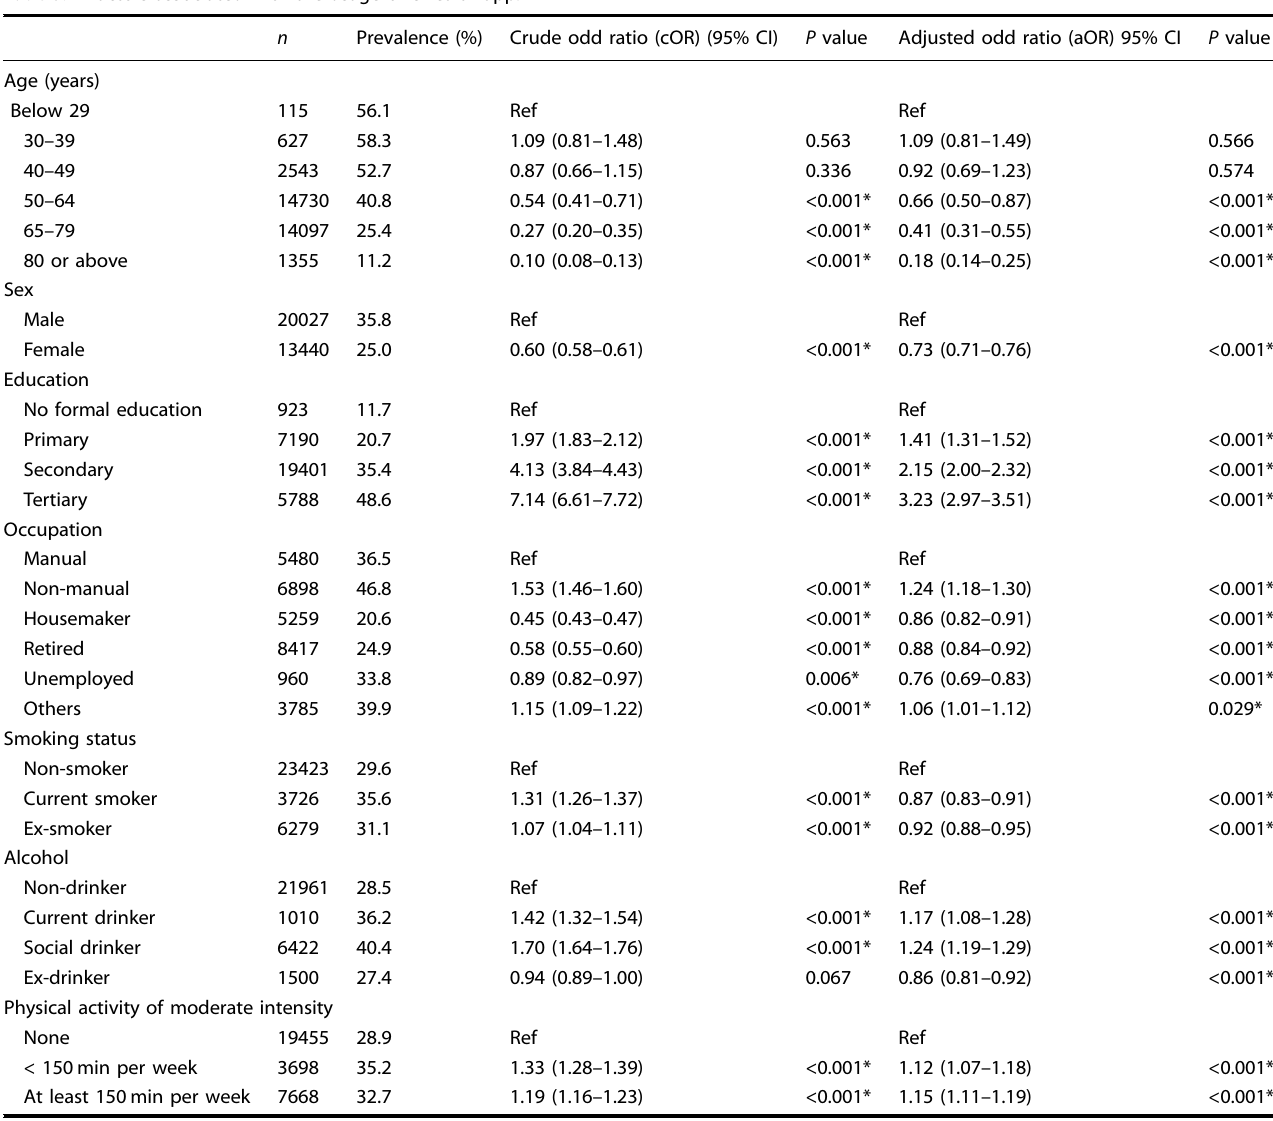
Table 5. Factors associated with the usage of eHealth